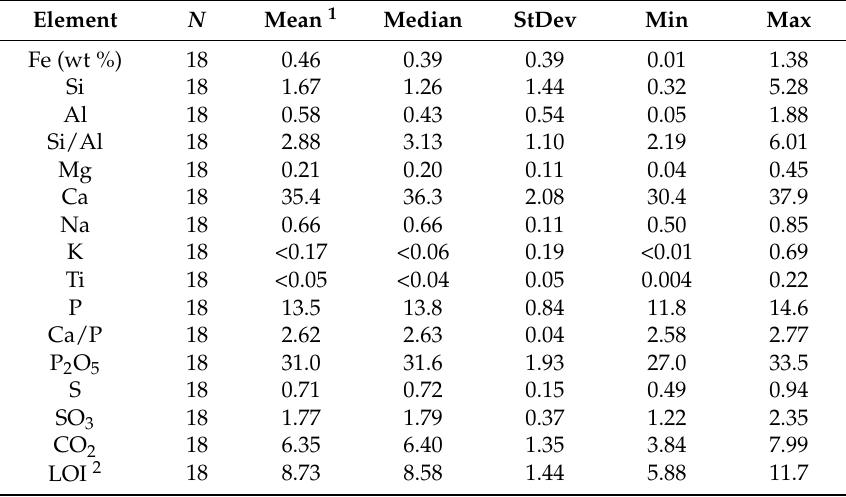
Table 8. Statistics of leached phosphorite deposits from seamounts a